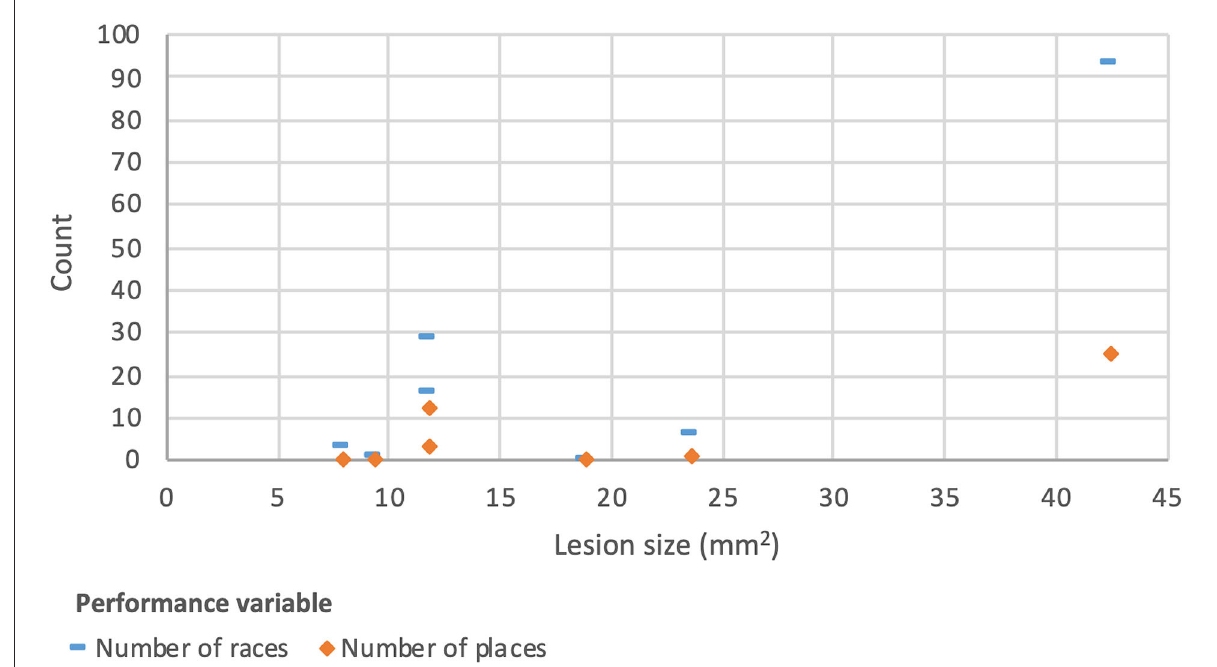
FIGURE7 Scatter plot showing distribution of P2SC size by number of races and places ( N =